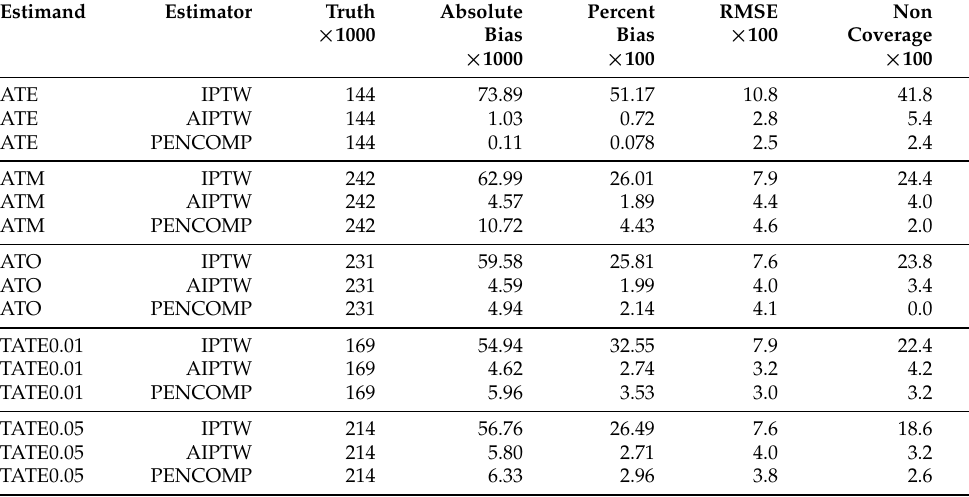
Table 6. Empirical bias (in absolute and percentage), RMSE, and 95% CI (non) coverage, across the methods for a binary outcome in the scenario where the propensity score models were misspecified. Results were based on 500 simulations with sample size of 500; 500 bootstraps were used to estimate standard errors for the weighted estimators and 200 complete datasets for PENCOMP. ATE = Average treatment effect; ATM = average treatment effect on an evenly matchable set; ATO = average treatment effect on the overlap population; TATE α = truncated average treatment effect with a truncation at a pre-defined α